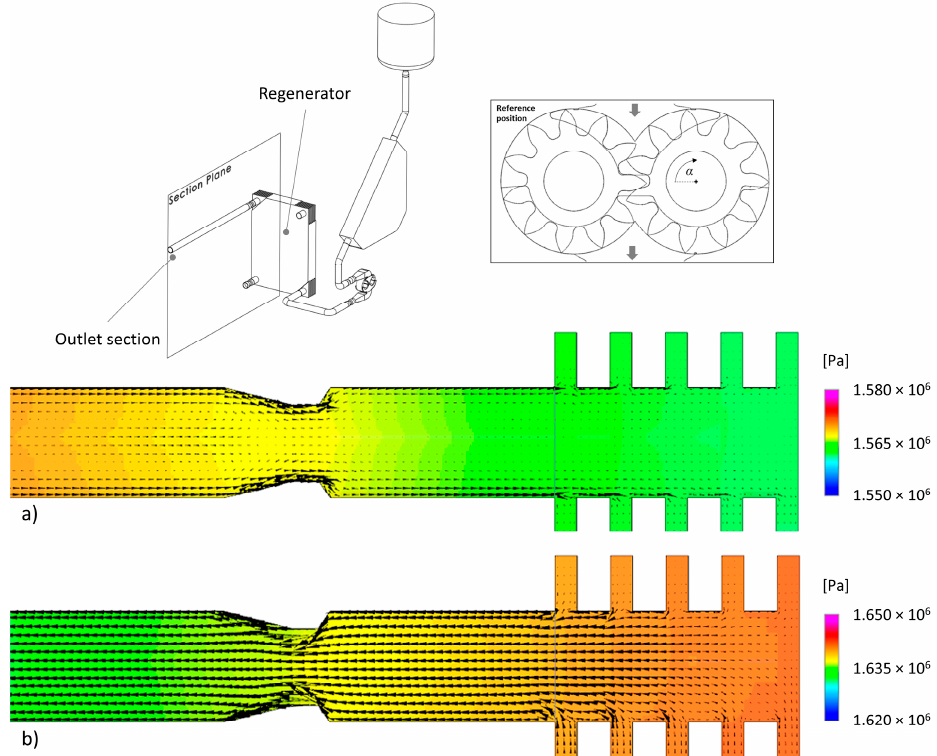
Figure 11. Pressure field and velocity vector at the regenerator outlet section at ( a ) 0° and ( b ) 16.5° (according to the reference position).